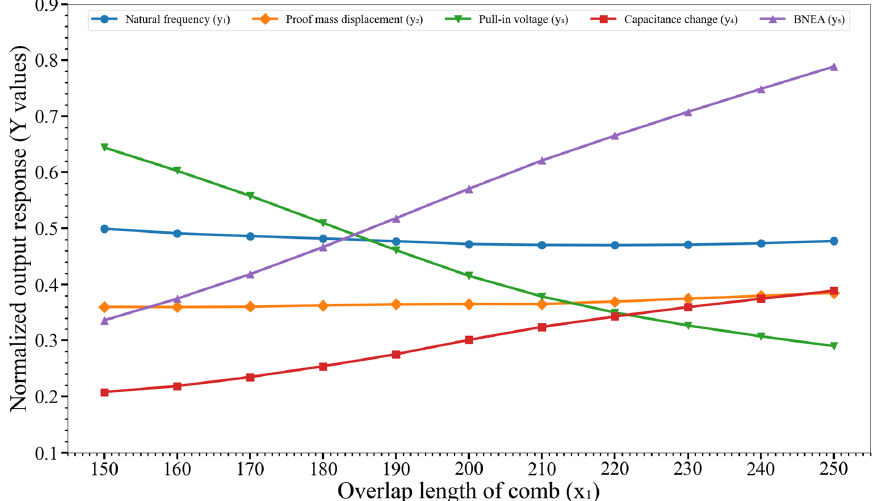
Figure 7. E ff ect of variation of the overlap length of comb (x 1 ) on the output responses y 1 , y 2 , …, y 5